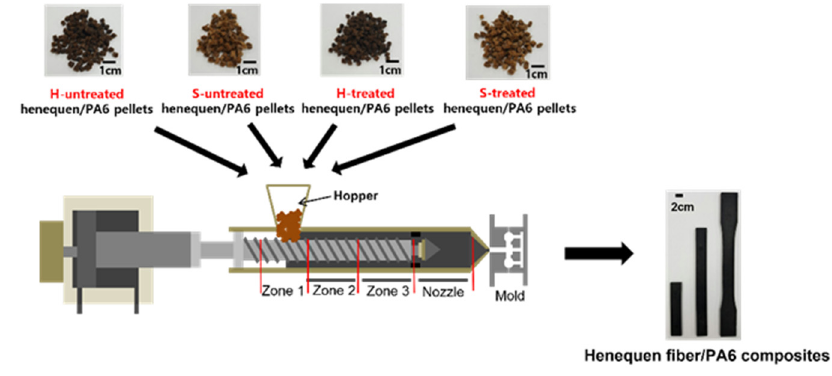
Figure 3. Illustration showing injection molding process to fabricate untreated and alkali-treated henequen fiber/PA6 composites.